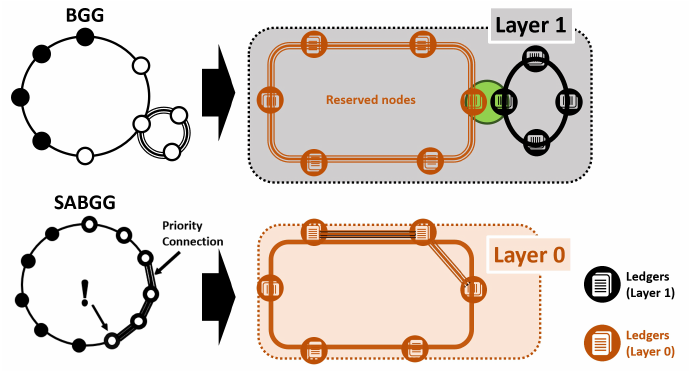
Figure 2. BGG and SABGG mapping into